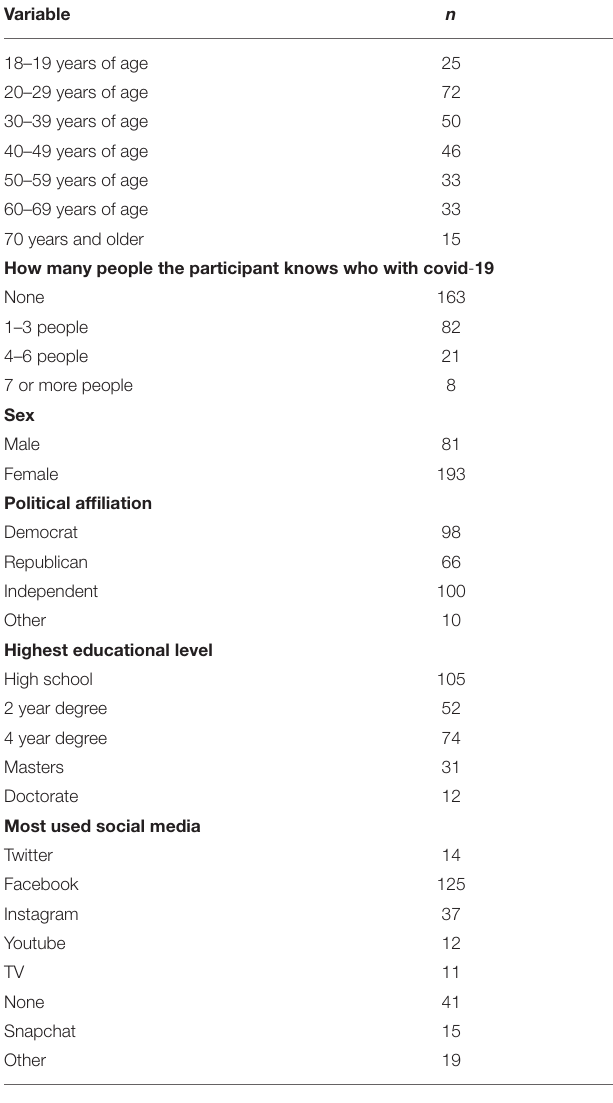
TABLE 1 | Participant